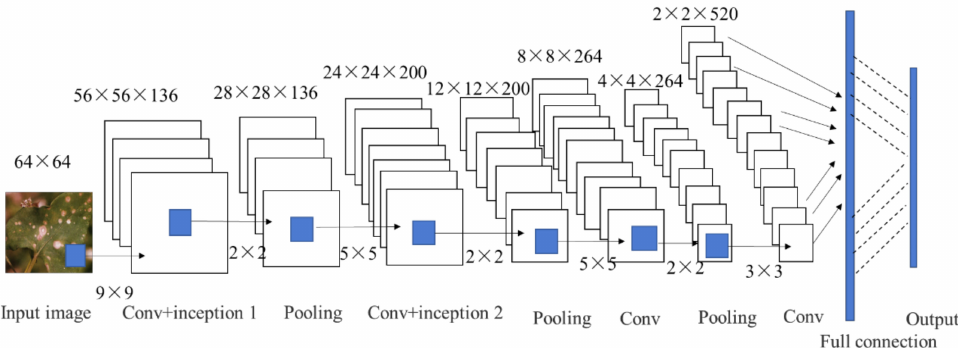
Figure 6. The structure of the convolutional neural network for buckwheat disease